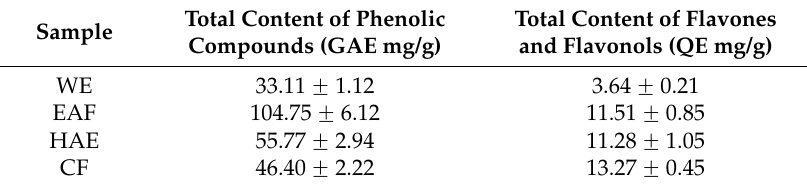
Table 1. Total content of polyphenols, flavones and flavonols in the studied extracts and fractions. Each value represents the mean ± SD of three independent measurements.